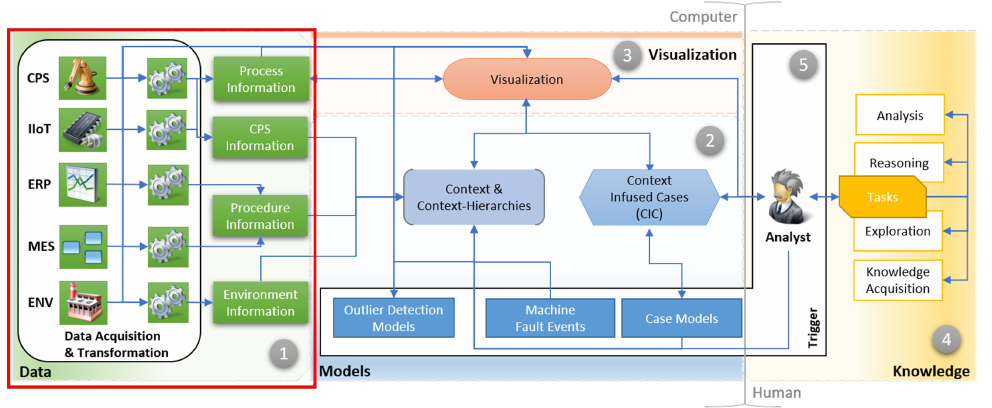
Figure 1. The TAOISM model [3]. The model reflects the context-aware diagnosis in smart manu- facturing. The four main areas are Data (1), Models (2), Visualization (3) and Knowledge (4) and they align with the general VA model by Keim et al. [7], extended with a new meta-layer (Trigger, 5). The contribution adds to the model’s data acquisition (red squared). Adapted with permission from [3], “Context-Aware Diagnosis in Smart Manufacturing: TAOISM, An Industry 4.0-Ready Visual Analytics Model”; published by Springer Nature,